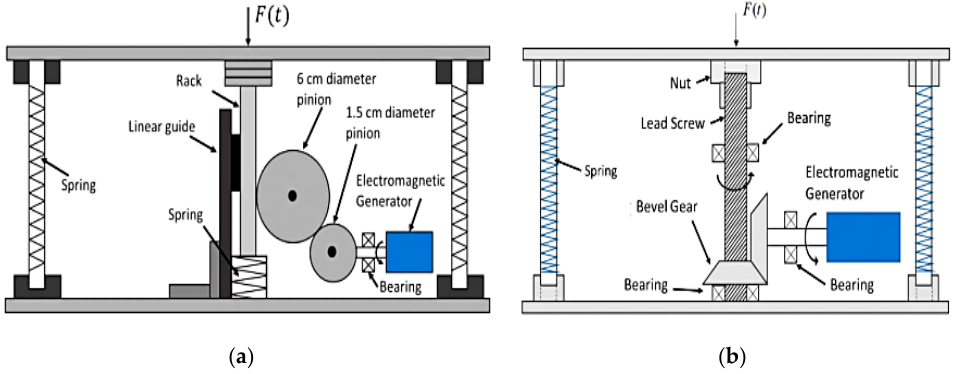
Figure 19. Two different mechanical configurations applied to electromagnetic smart tiles: rack-pinion model ( a ), lead-screw model ( b ) [36].